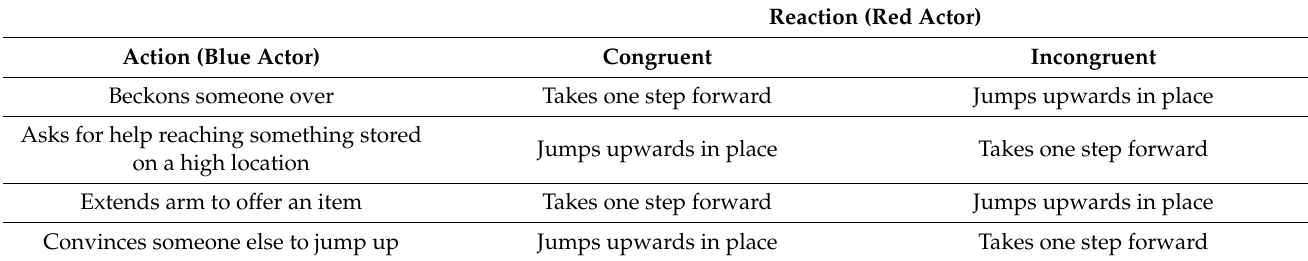
Table A4. Action–reaction sequences in Block D.